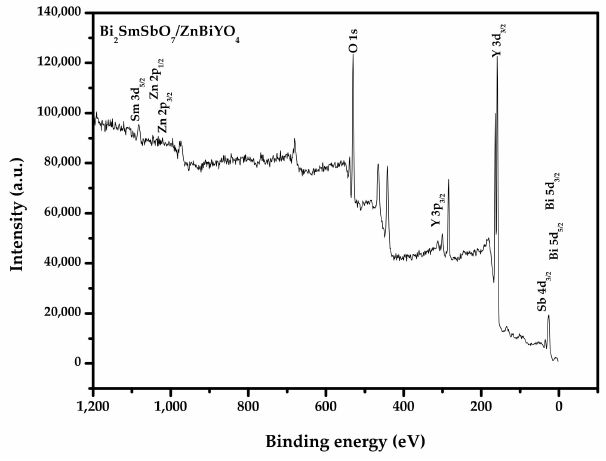
Figure 7. XPS survey spectrum of the Bi 2 SmSbO 7 /ZnBiYO 4 heterojunction